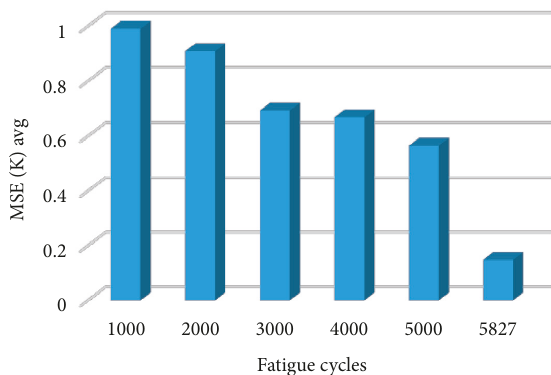
Fatigue cycles Figure 10: Mean value of K multi-scale entropy (MSE(K)avg).